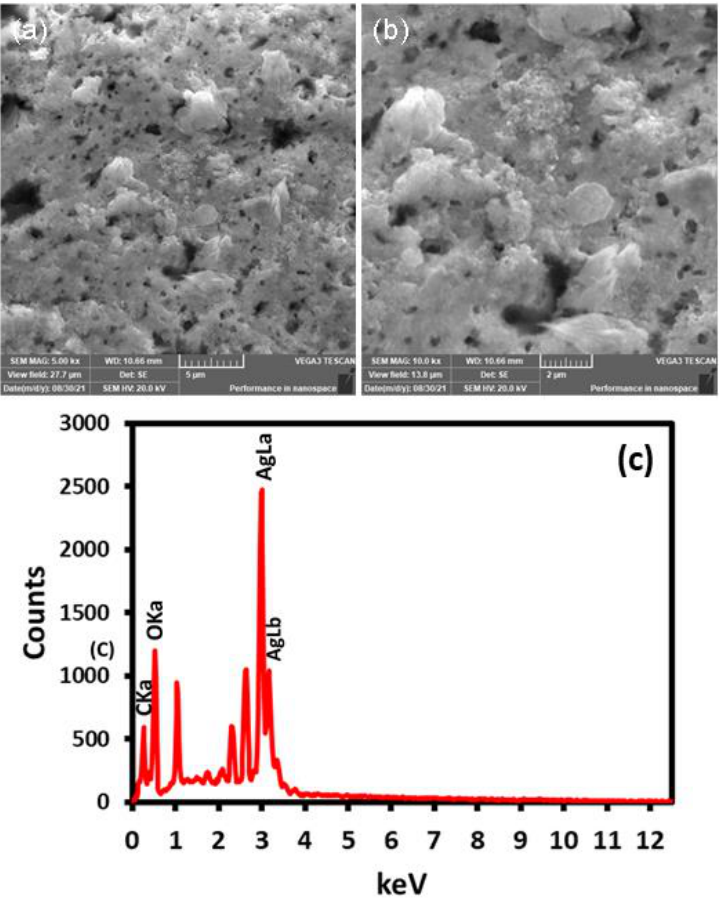
Figure 4. ( a , b ) scanning electron microscopy of the AP-AgNPs at two magnifications (5 and 10 kX) and ( c ) EDX analysis and elemental composition of the